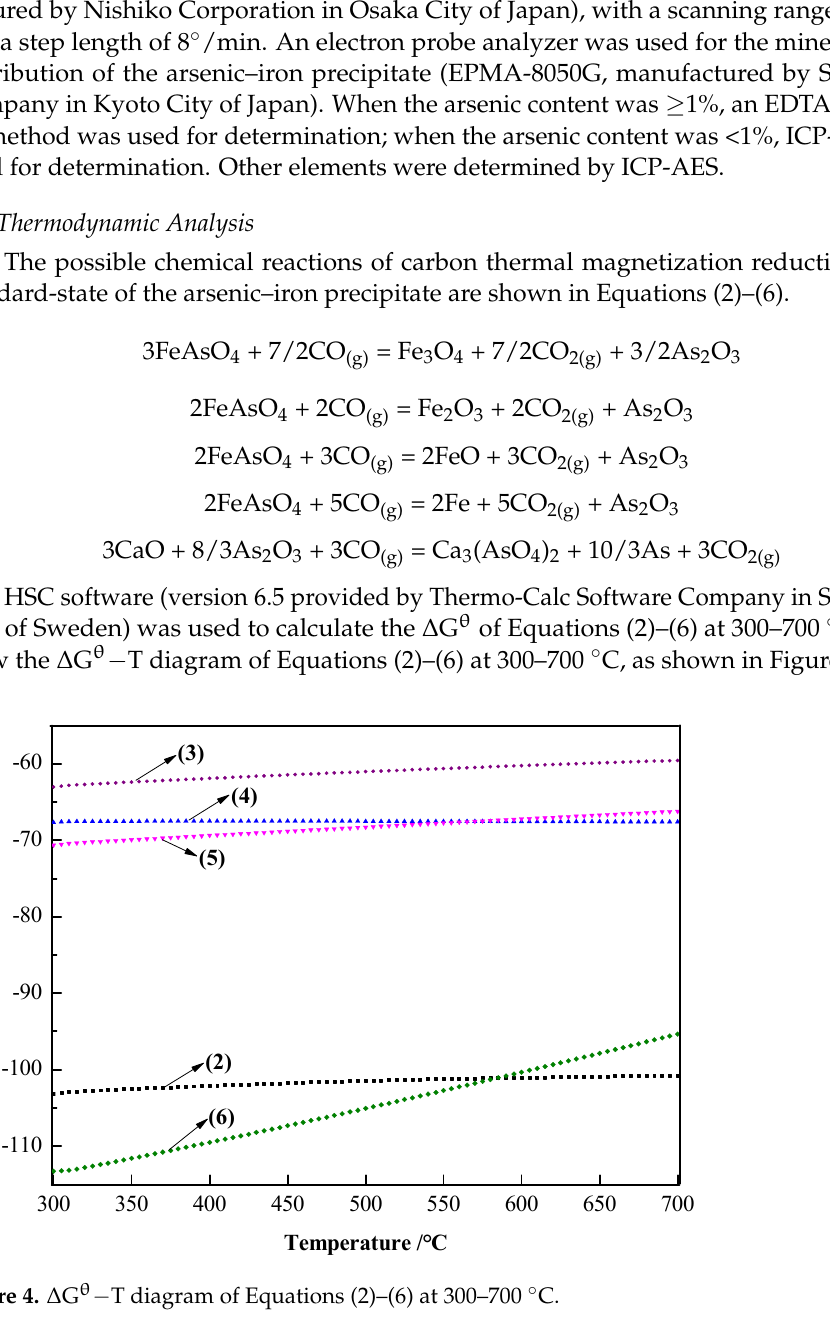
Figure 4. Δ G θ − T diagram of Equations (2)–(6) at 300 − 700 °C . Figure 4. ∆ G θ − T diagram of Equations (2)–(6) at 300–700